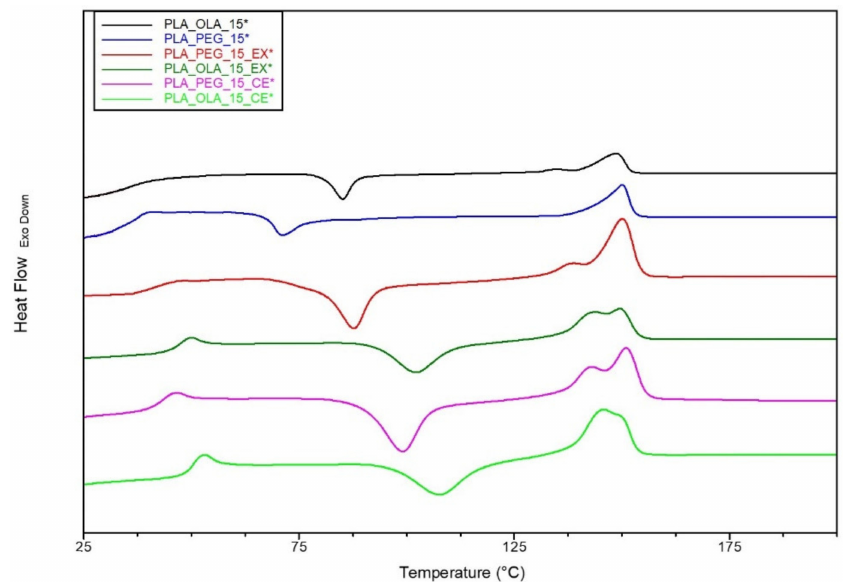
Figure 12. Differential scanning calorimetry (DSC) thermograms of the first-heating up-scaled film formulations. Table 4. DSC results of the first-heating up-scaled film